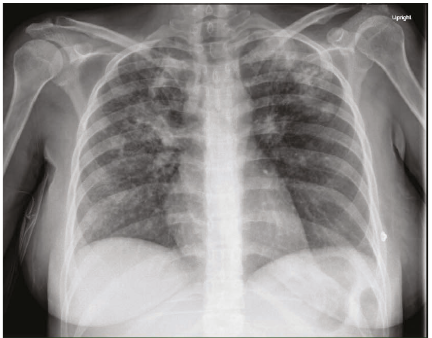
Figure 1: Chest X-ray image showing both alveolar and interstitial infiltrates with findings most prominent within the bilateral upper lobes and right perihilar region.